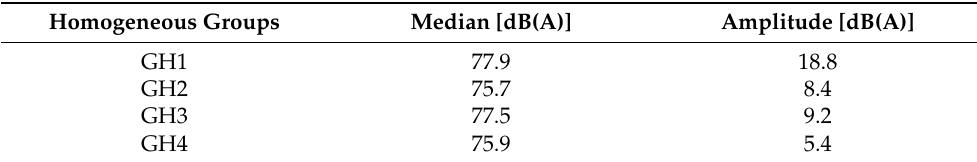
Table 4. Median and amplitude of the sound pressure level in homogeneous groups.